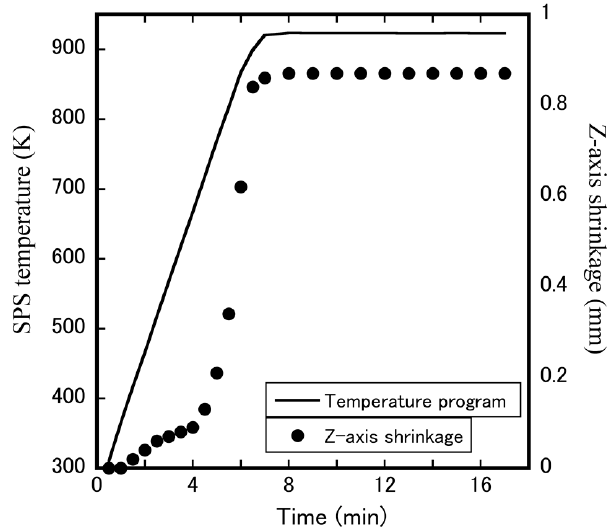
Figure 5. Z -axis linear shrinkage of pre-calcination ZrW 2 O 8 powders during SPS.